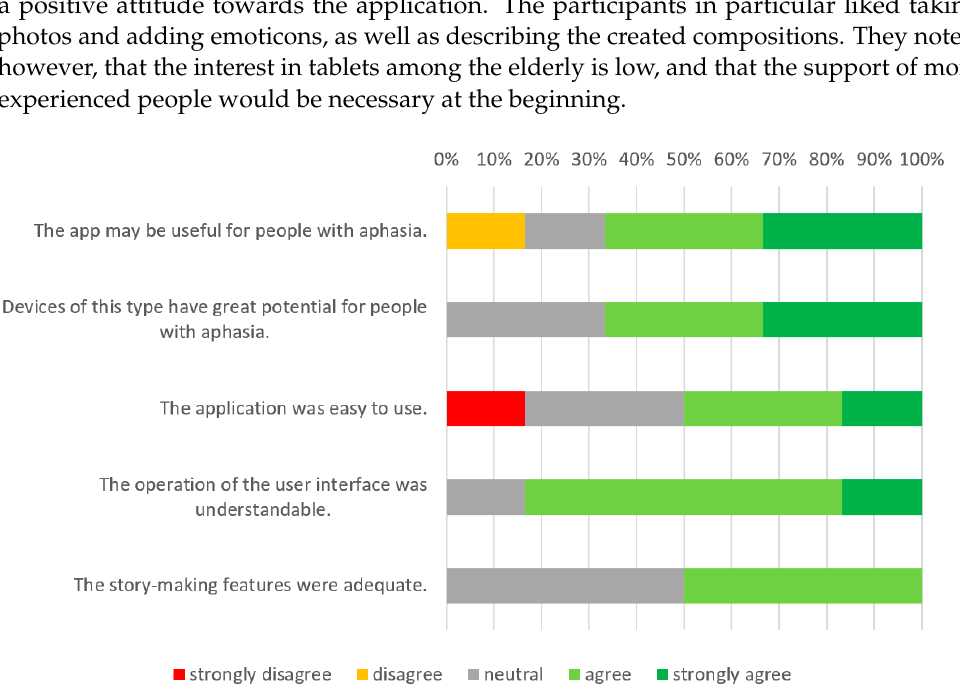
Figure 14. Results of the post-test survey for the Aphasia Create app.